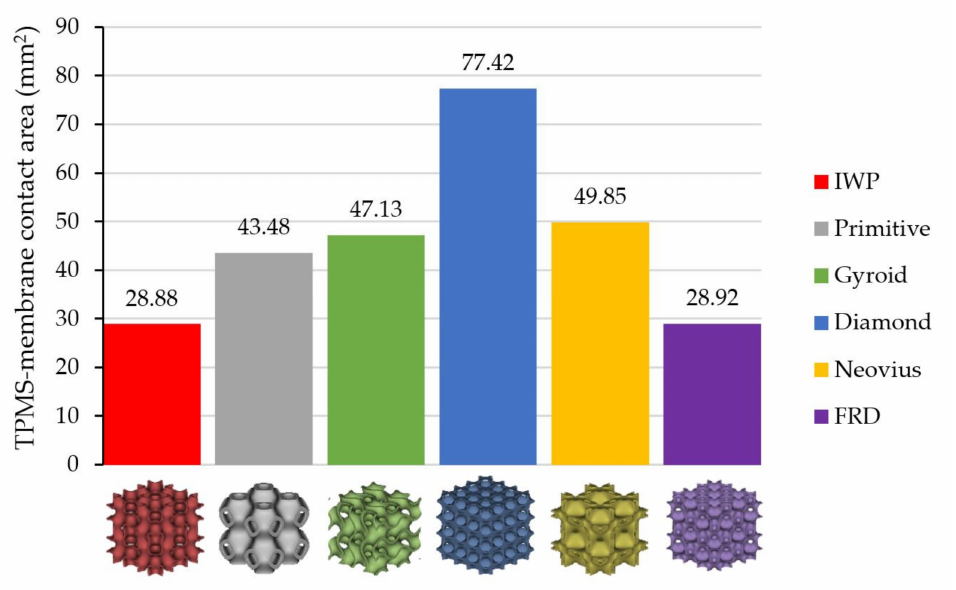
Figure 15. The value of the TPMS-membrane contact area of each TPMS